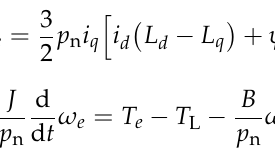
Figure 1. Equivalent winding diagram of PMSM in d ‐ q coordinate system. ( a ) d axis equivalent cir ‐ cuit . ( b ) q axis equivalent circuit.